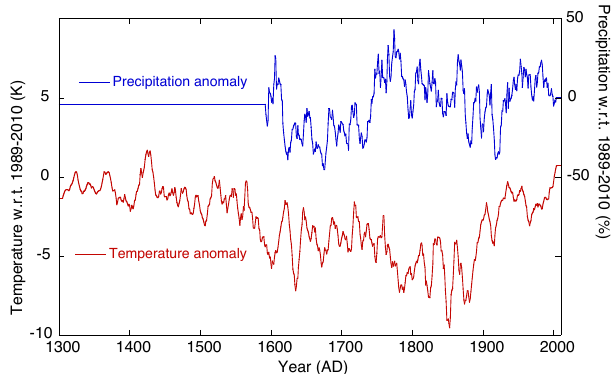
Fig. 7. Time series of reconstructed air temperature (red) and precipitation (blue) relative to the mean over the reference pe- riod 1989–2010. A 10yr smoothing filter is applied. Precipitation anomalies are given in percentages, whereas temperature anomalies are absolute